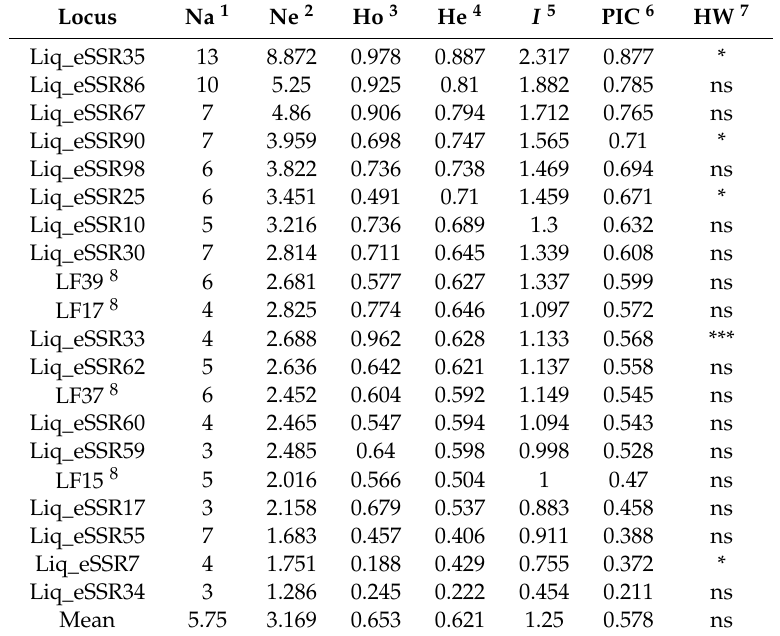
Table 4. Diversity information parameters for 20 SSR loci in 53 individuals of L. formosana.